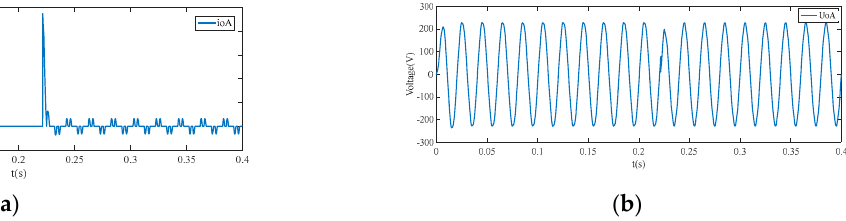
Figure 11. Simulation results of UPS with rectifier load using VSG control strategy and dynamic switching method ( a ) load current of phase A 𝑖 (cid:3042)(cid:3002) , ( b ) load voltage of phase A 𝑈 (cid:3042)(cid:3002) , 𝐶 (cid:3045)(cid:3030) = 5500 µF, 𝑅 (cid:3045)(cid:3030) = 16 Ω . Figure 12. Simulation results of UPS with rectifier load using VSG control strategy and dynamic switching method ( a ) load current of phase A 𝑖 (cid:3042)(cid:3002) , ( b ) load voltage of phase A 𝑈 (cid:3042)(cid:3002) , 𝐶 (cid:3045)(cid:3030) = 9900 µF, 𝑅 (cid:3045)(cid:3030) = 16 Ω .